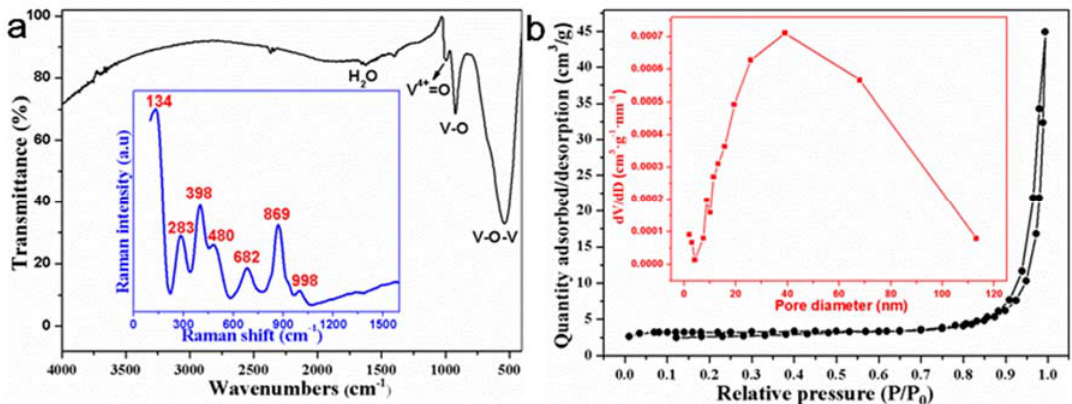
Figure 5. ( a ) IR and Raman spectra of VO 2 (B) nanobelts; ( b ) N 2 adsorption ‐ desorption isotherms of the VO 2 (B) nanobelts at 77 K.